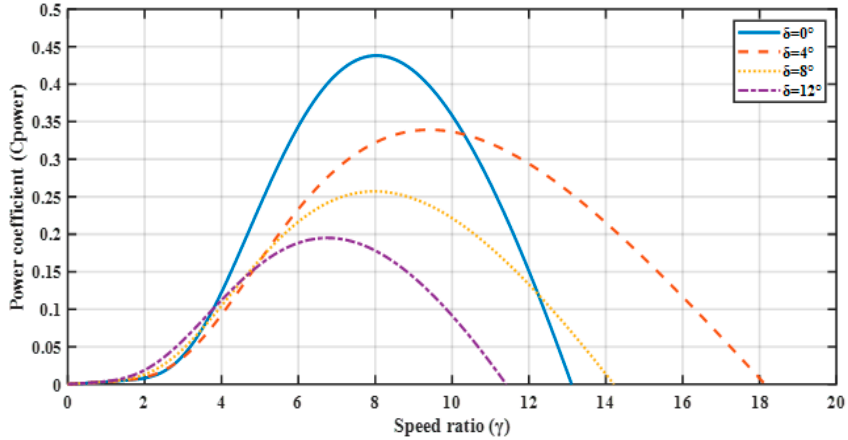
Figure 11. Curves of 𝐶